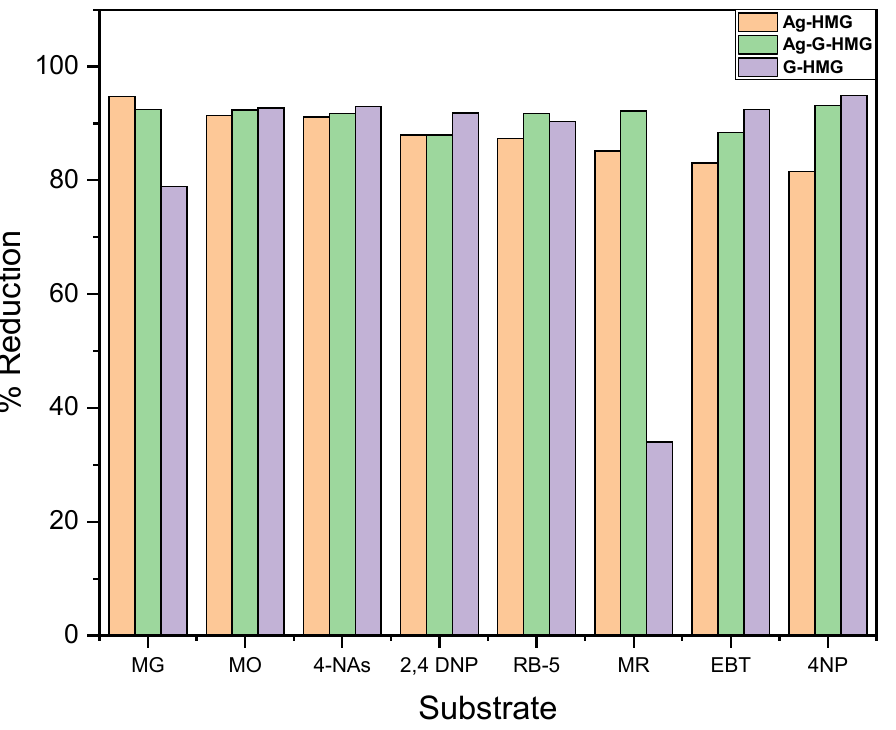
Figure 5. A plot of comparisons of the reduction percentages of different substrates reduced through the use of different hybrid microgels as catalysts. A summary of the reduced concentrations of different substrates is provided in Table 1. The N-group (the group containing nitro) was reduced into the A-group (the group containing amino), and the A-group was reduced into N–N in the excess presence of NaBH 4 using a synthesized catalyst (Ag-HMG, Ag-G-HMG, and G-HMG), which resulted in reduced (colorless) compounds. C i , C f , and C r concentration details are also shown. Substrates were reduced into 4-AP, 2,4-DAP, 4AAS, and other amino compounds. The synthesized G-HMG catalyst showed a maximum reduction of different substrates as compared to Ag-HMG and Ag-G-HMG. Table 1. Comparison of initial, final, reduced concentrations and reduction time of substrates using Ag-HMG, Ag-G-HMG, and G-HMG hybrid microgels, respectively, as catalysts.